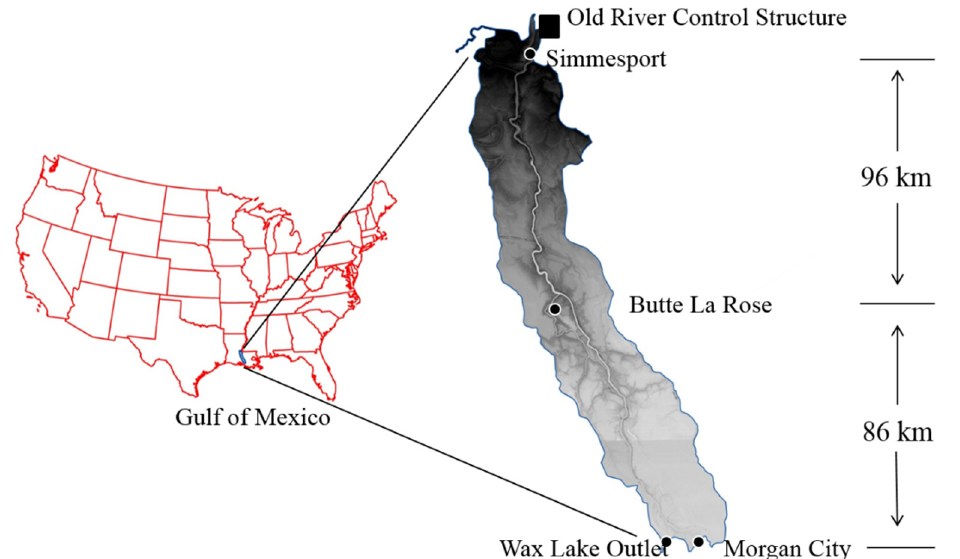
Figure 1. Geographical location of the Atchafalaya River Basin to the Northern Gulf of Mexico in the southern United States. The river carries ~25% of the Mississippi River’s water diverted by the Old River Control Structure and the entire flow of the Red River, forming the North America largest river swamp. In this study three sampling sites were chosen for in situ measurements and water sampling: Simmesport (30°58’05.9”N, 91°48’26.2”W) being upstream and two outlets downstream at Wax Lake Outlet and Morgan City (29°42’03.2”N, 91°22’17.6”W; 29°41’50.5”N, 91°12’41.9”W, respectively).